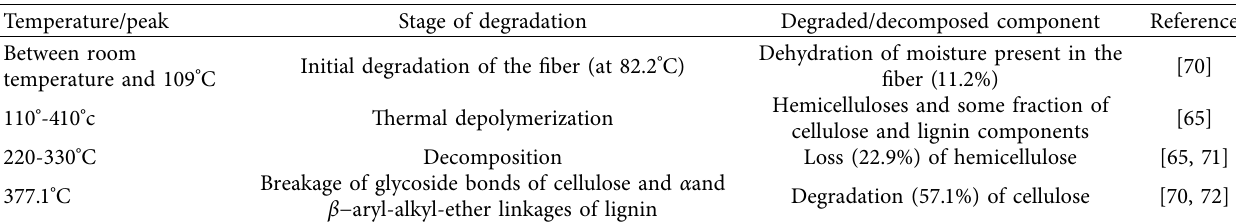
Figure 5: Thermogravimetric of extracted CDA fibers and DTG vs TGA. Table 3: Summary of TGA result.